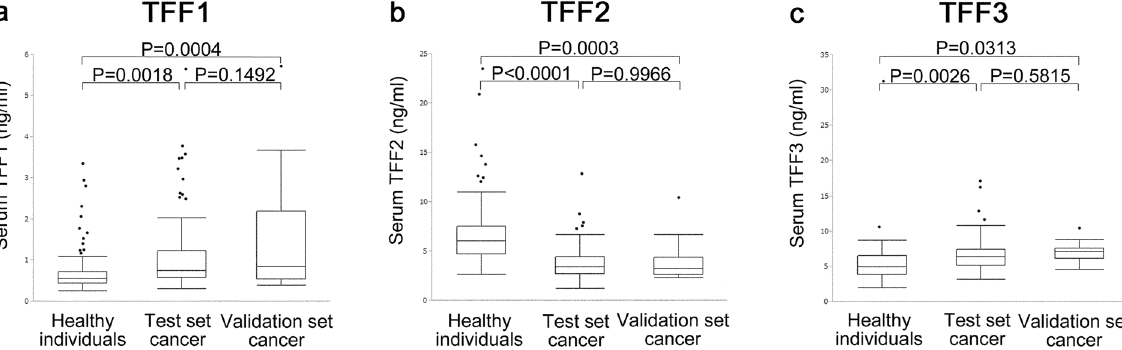
Figure 1. Serum TFF1, TFF2, and TFF3 values of healthy individuals and breast cancer patients. Serum TFF1, TFF2, and TFF3 values ( a – c ) of healthy individuals, breast cancer patients in test set, and breast cancer patients in validation set. Serum TFF1 and TFF3 levels in test set breast cancer patient were significantly higher than in healthy individuals ( a and c ) (P = 0.0018 and P = 0.0026). Serum TFF2 in test set breast cancer patient level was significantly lower than in healthy individuals ( b ) (P < 0.0001). Similarly, serum TFF1 and TFF3 levels in validation set breast cancer patient were significantly higher than in healthy individuals ( a , c ) (P = 0.0004 and P = 0.0313). Serum TFF2 level in validation set breast cancer patient was significantly lower than in healthy individuals ( b ) (P = 0.0003). There was no significant difference in serum TFF1, TFF2 and TFF3 between test set and validation set. Serum TFF (ng/ml) value in the vertical